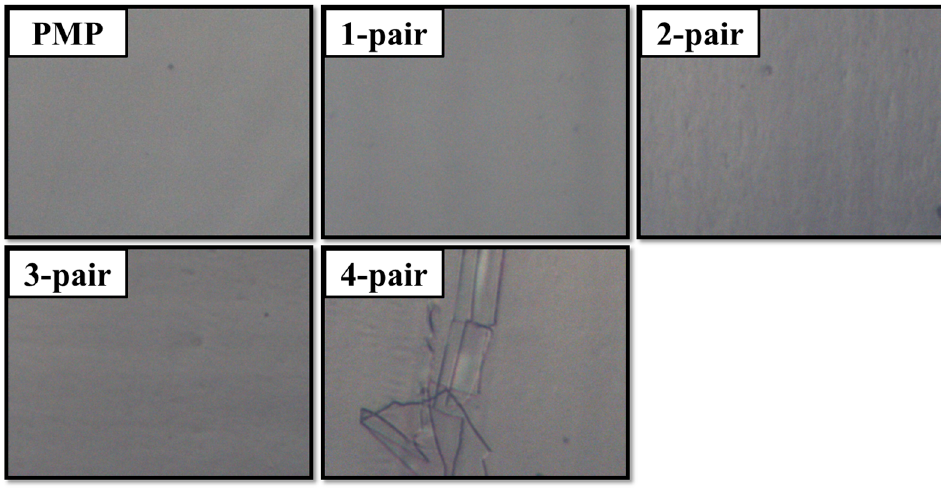
Figure 1. Optical microscope images of the polymethylpentene (PMP) without, with one-, two-, three- and four-pair SiO x /SiC x H y films. and four-pair SiO x /SiC x H y